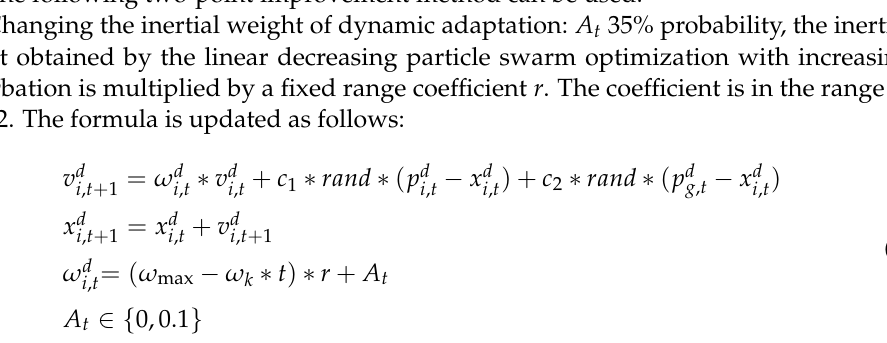
Figure 2. The relation curve of inertial weight and iterations under linear decreasing with constant perturbation increased.